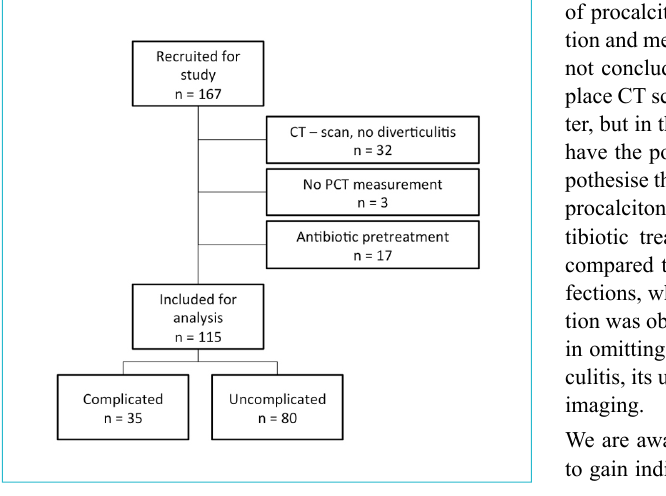
Figure 1: Included and excluded patients. All recruited patients gave written informed consent. Patients were excluded for analysis